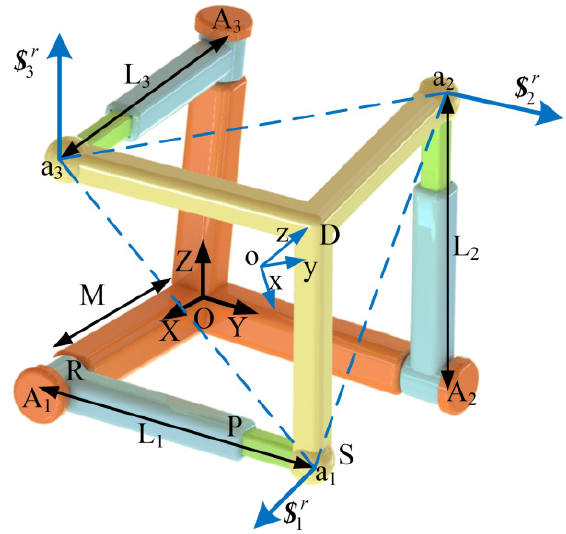
Figure 14. The structure and constraint wrench screws of a 3 − RPS pyramid mechanism. i = $ on the moving platform. Limb i imposes a constraint wrench screw 1,2,3) r i